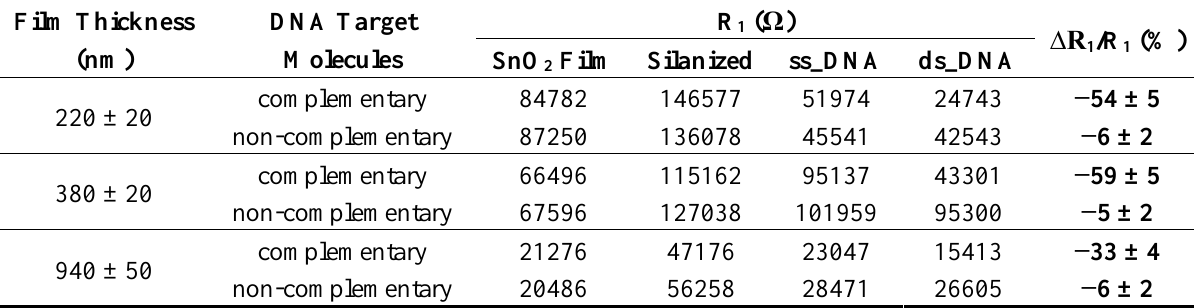
Table 3. Resistance value R 1 obtained from fitting of the Nyquist plot of nanoporous SnO 2 electrodes with different film thickness after liquid phase silanization, after immobilization and after complementary or non-complementary DNA hybridization with target concentration of 2